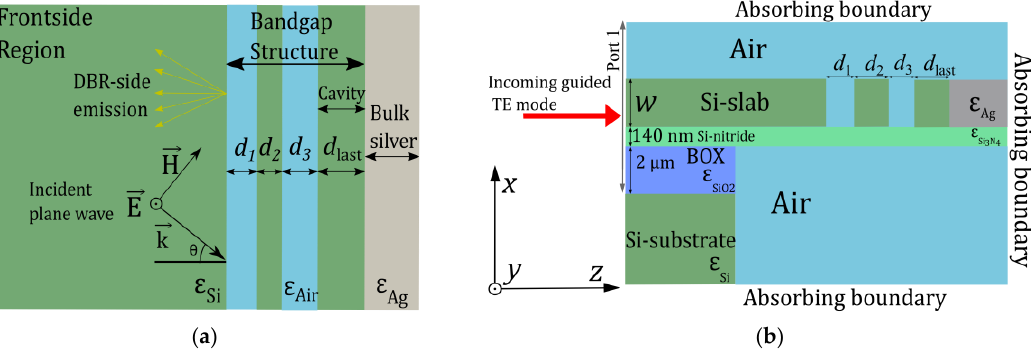
Figure 1. 1-D Simulation domain of the conventional 1D TP structure for the transfer-matrix method ( a ) and 2-D FEM simulation domain of the STP structure ( b ). The circle with the center dot indicates the out-of-plane y -axis.